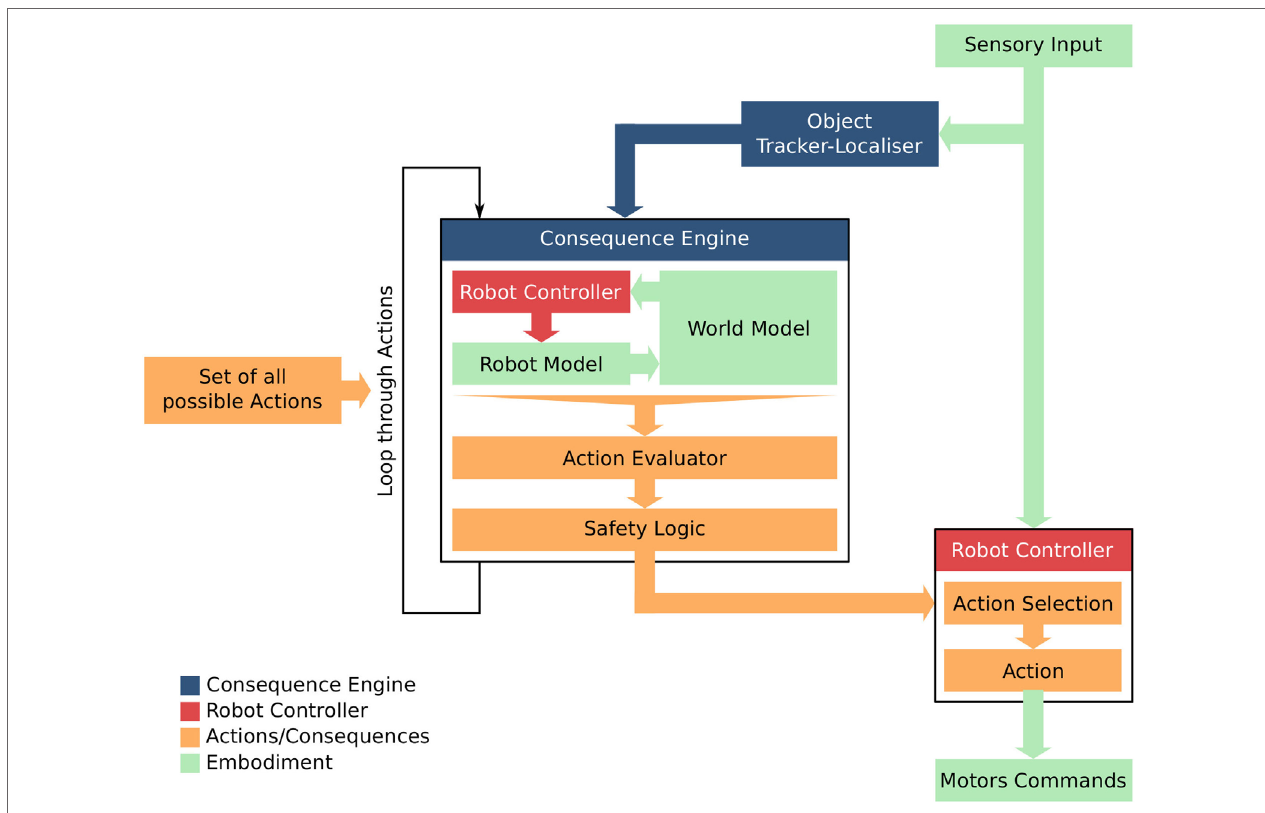
FigUre 2 | The Consequence Engine (CE) architecture, and its relationship with the robot’s controller. Modules dealing with different kinds of information are color coded.